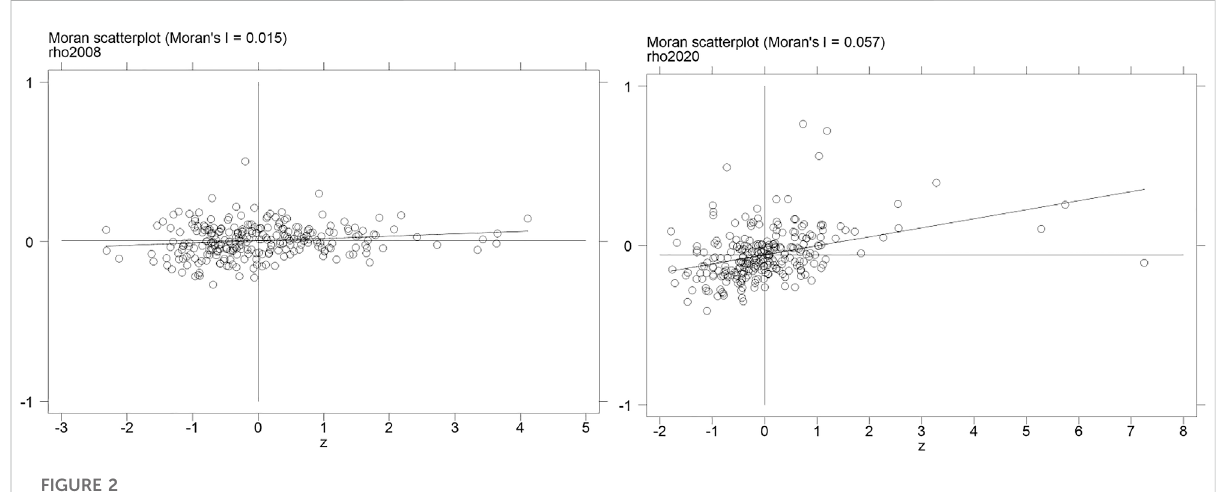
FIGURE 2 Scatter diagram of Moran ’ s I of Bias in China.